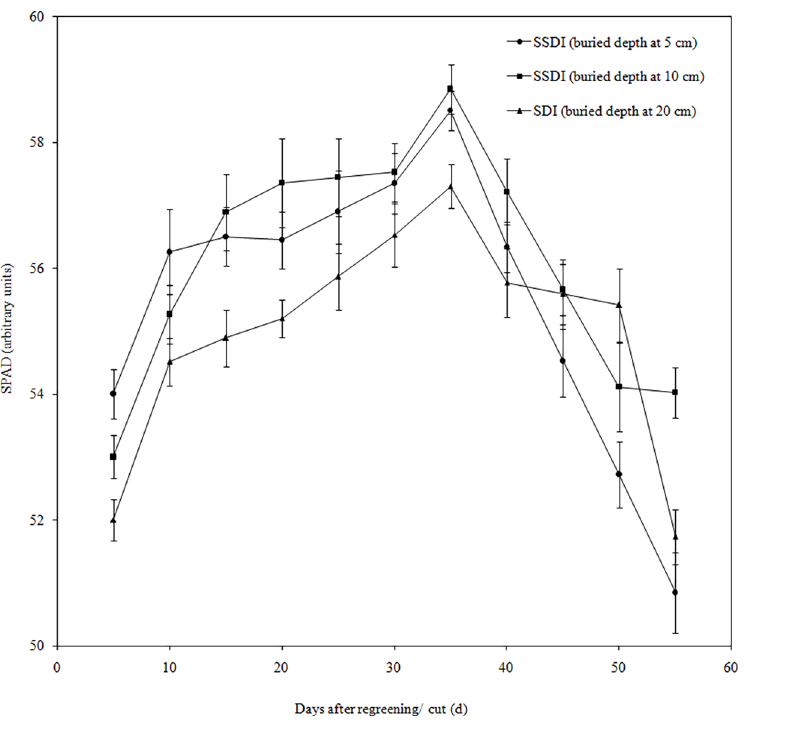
Fig 5. SPAD value of alfalfa during one fertility period.